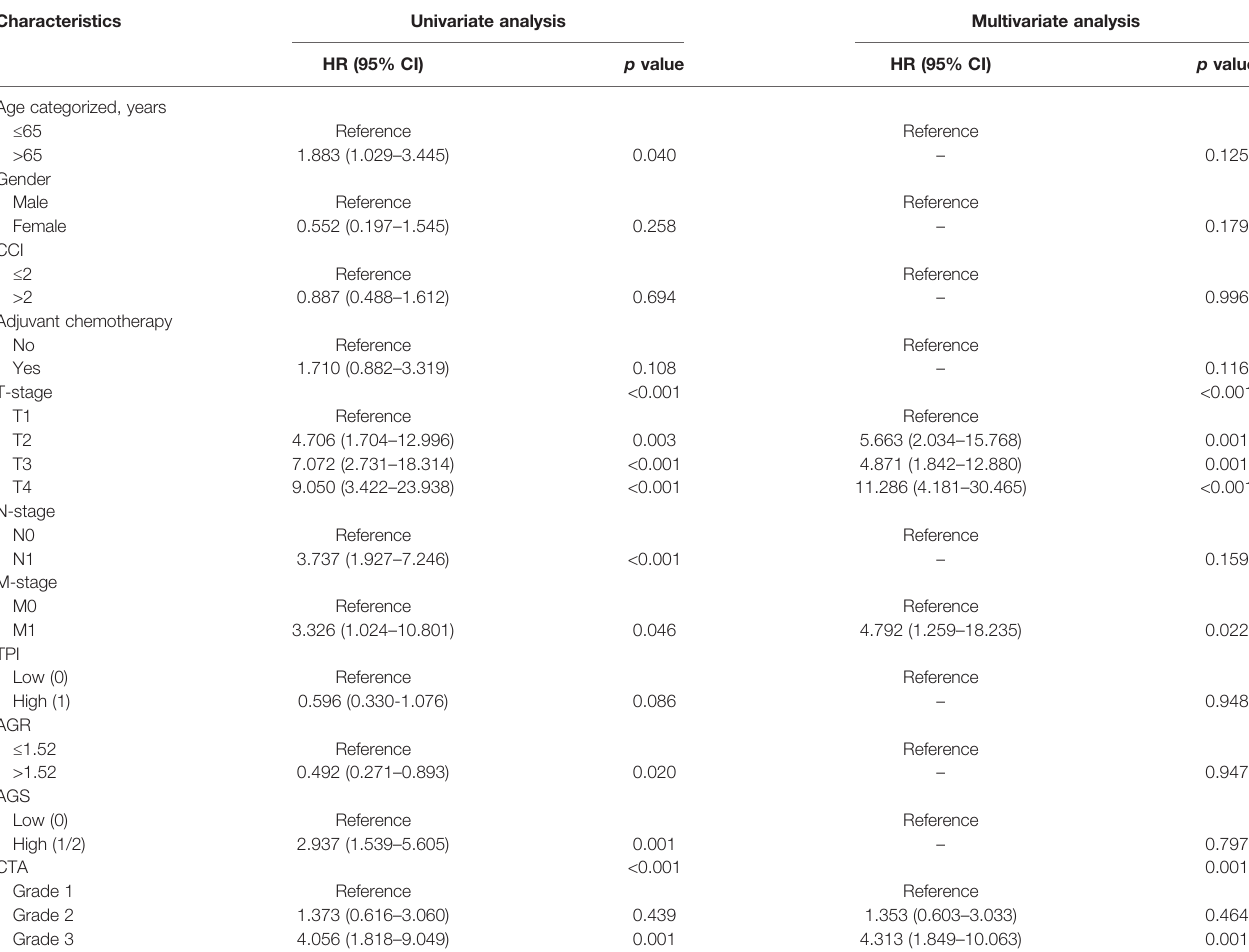
TABLE 6 | Univariate and multivariate analyses of factors associated with disease-free survival (DFS).